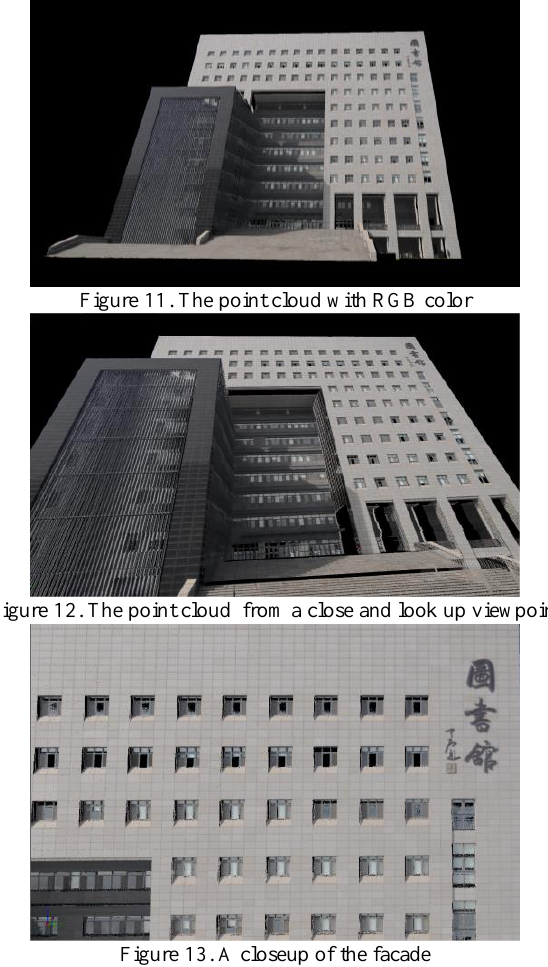
Figure 13. A closeup of the